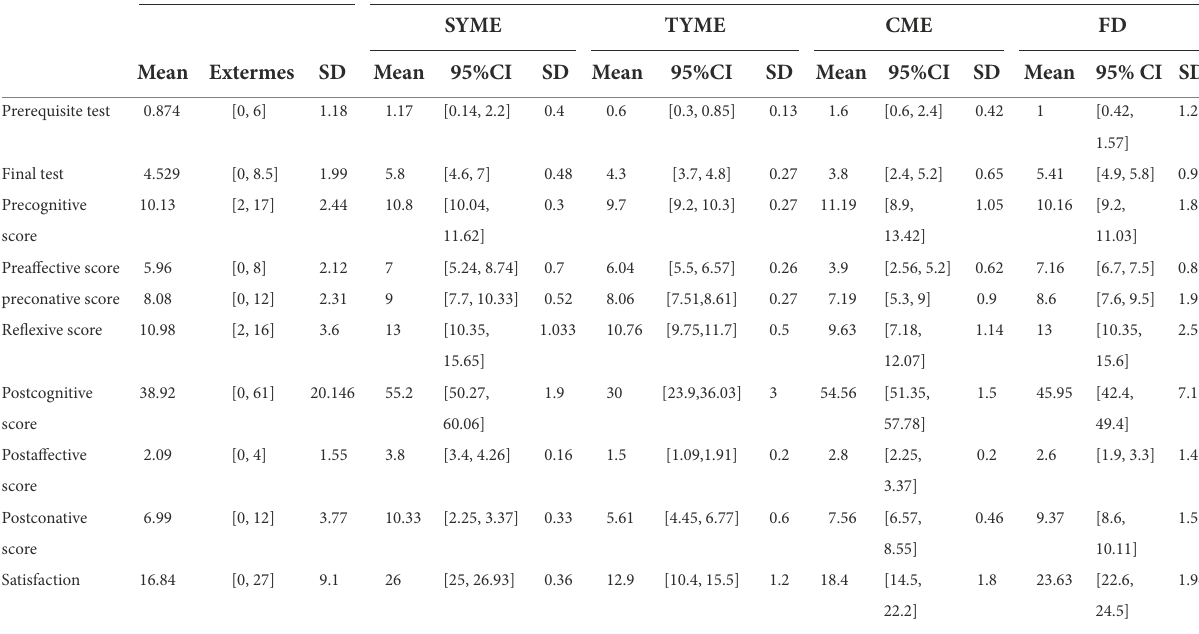
TABLE 2 Detailed results of the general means and the means according to the students’